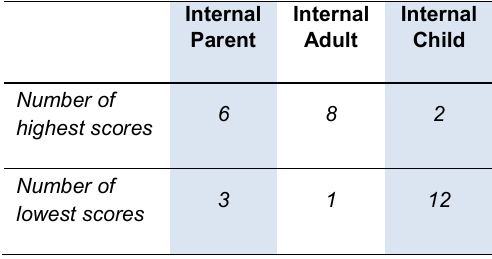
Table 2: Highest and lowest scores on Internal Ego- State Questionnaire (Hay 1996)